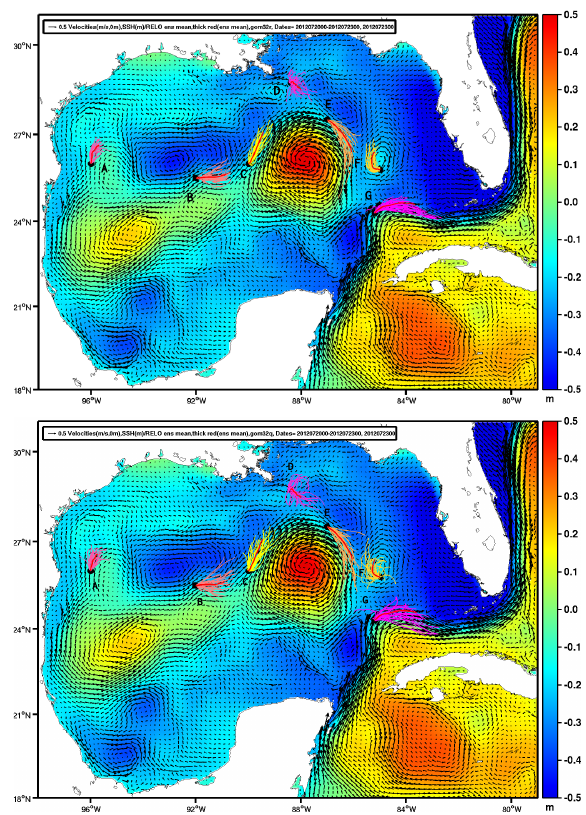
Fig. 10. The trajectories of 7 particles (A, B, C, D, E, F, G) predicted by ensemble members from r (top panel) and q (bottom panel). The predicted trajectories by ensemble means are denoted by thick red curves. Particle D is chosen to be at the location of DWH accident. Superimposed are the SSH in color contour, and surface water velocity indicated by